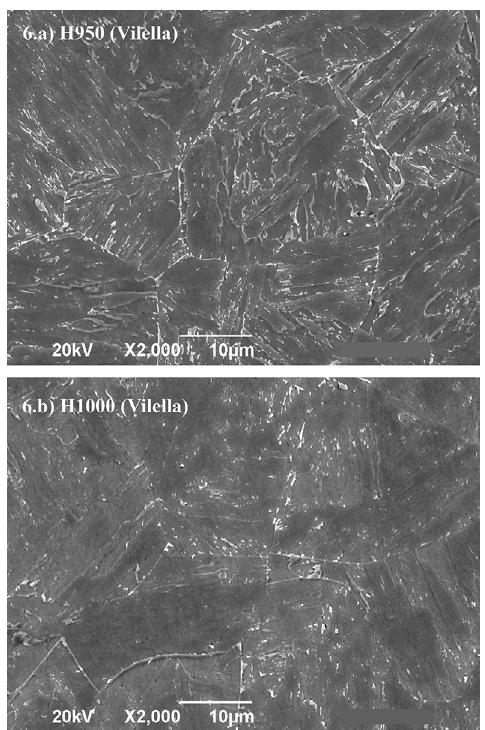
Figure 6. SEM images of (a) H950 and (b) H1000, etched with Vilella, showing the quantity difference of white